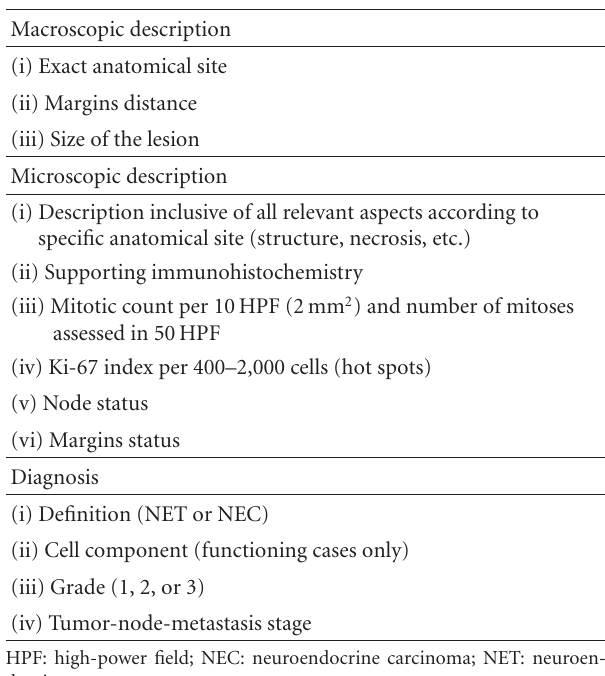
Table 2: Pathology report recommendations for pancreatic neuroe- ndocrine tumors (PNETs)